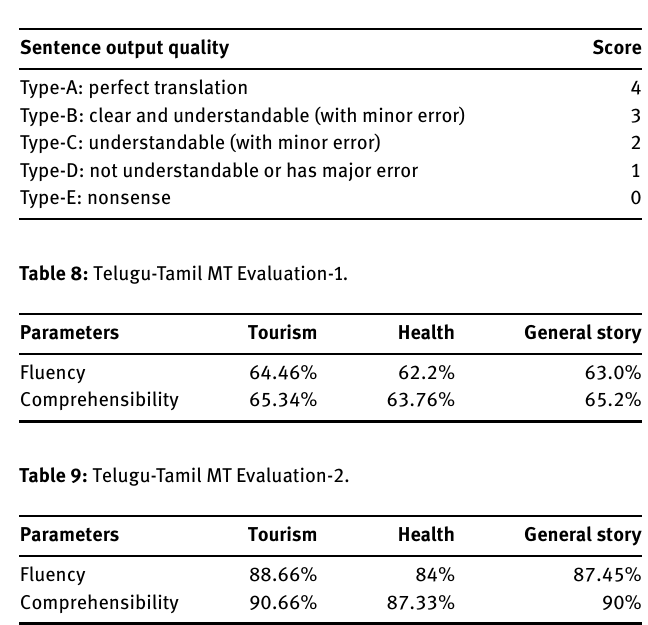
Table 7: MT Human Evaluation Scale.